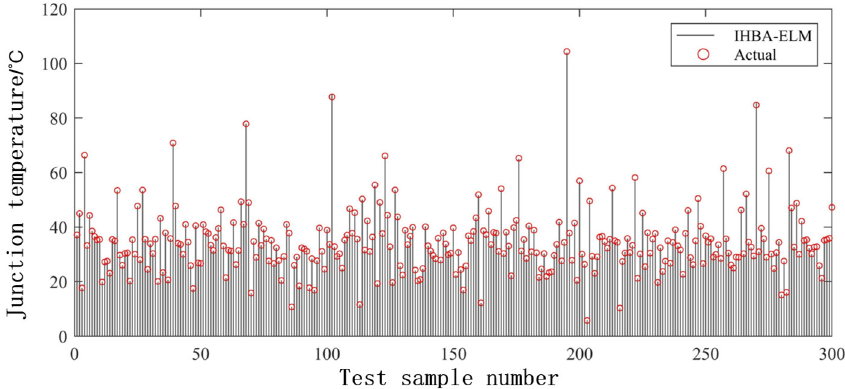
Figure 9. Predicted junction temperature of the IHBA-ELM model.